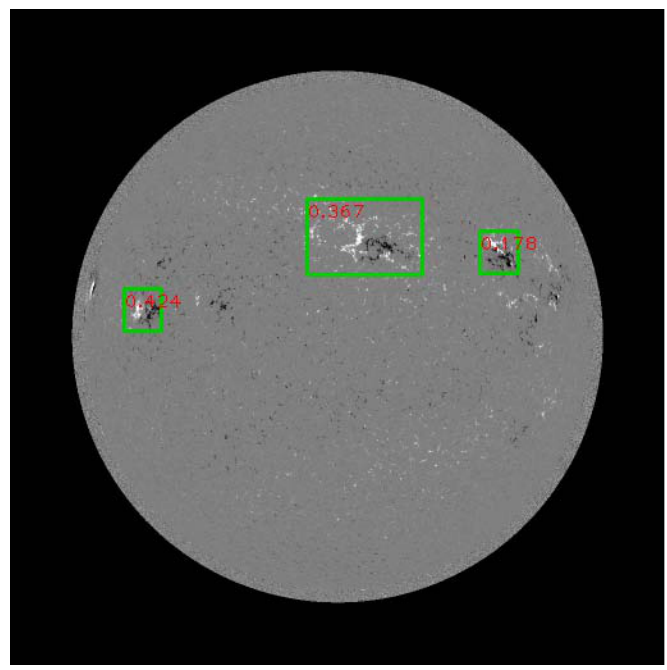
Figure 6. Example for the YOLO V3 detection of active region. A total of 572 magnetograms, labeled 601 active regions from 2016 to 2017, are used to test these two detection models, respectively. For the faster R-CNN model for active region detection, the TP rate is 90%, while the TN rate is 98%. Usually, small active regions or active regions at the edge of the solar disk are more likely to be missed because the active regions at the edge of the solar disk could be influenced by the projection effect